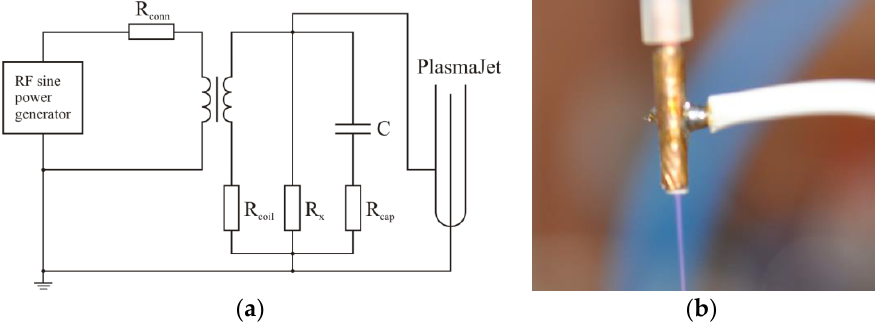
Figure 22. ( a ) APPJ power supply system with separated resonant sub-circuit. ( b ) Picture of the reactor.